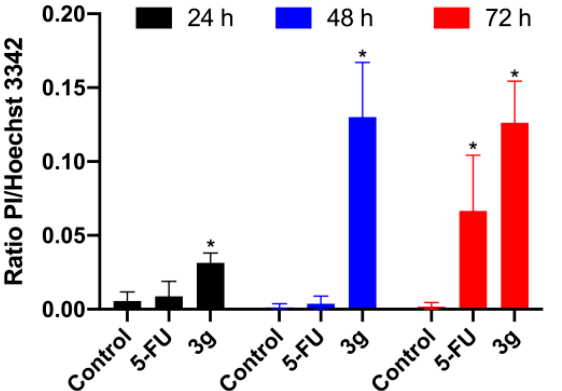
Figure 2. Ratio of PI/Hoechst 3342 staining results. T47-D cells were incubated during 24, 48 and 72 h with 5-fluorouracil (5-FU) and 3g at 20 µM. Untreated cells were considered the control of the experiment. Cells were visualized in an Axio Imager A1 microscope, and the resulting images were treated in ImageJ. Data are expressed as mean ± SD and represent at least two experiments. * p < 0.05 compared to control.